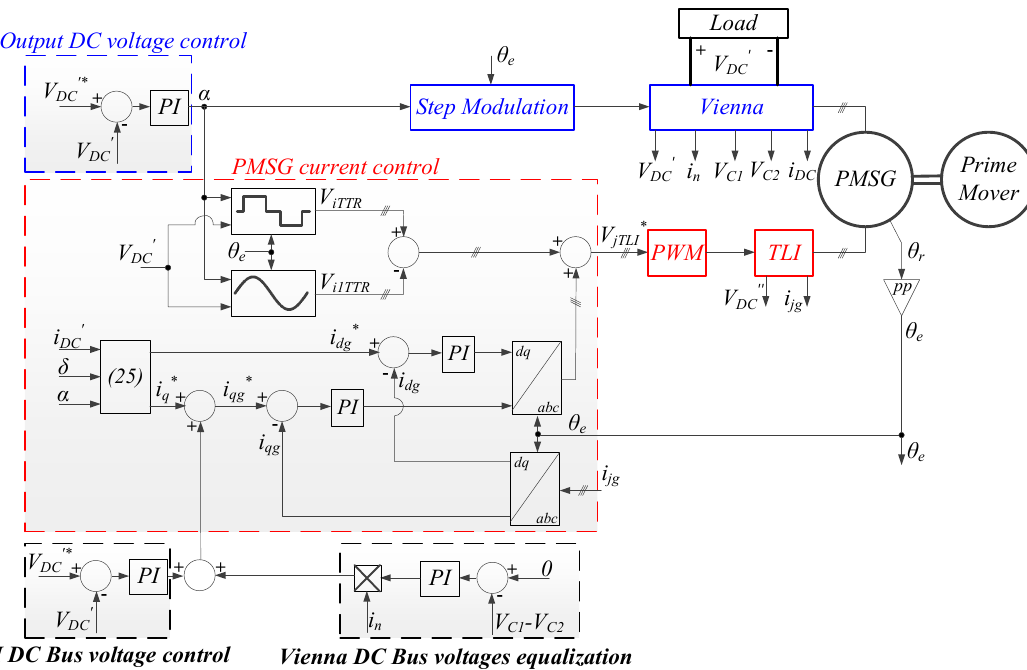
Figure 2. Block diagram of the control system of the AHUTR for electrical power generation applications.